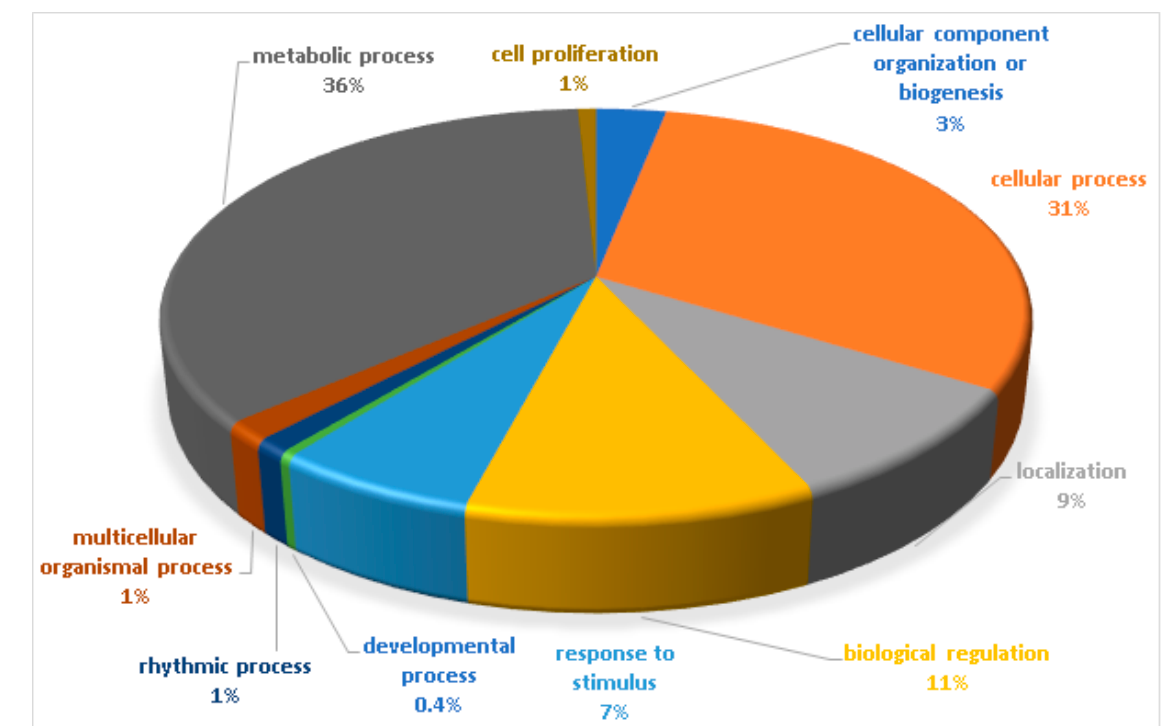
Figure 3. Biological functional classification of the identified phosphoproteins. The percentage of annotated proteins with each indicated gene ontology (GO) term is shown. The biological functions were classified in 10 different groups, mostly functioning in the metabolic process (36%) and the cellular process (31%). The common biological processes included biological regulation (11%), localization (9%), and response to stimulus (7%).